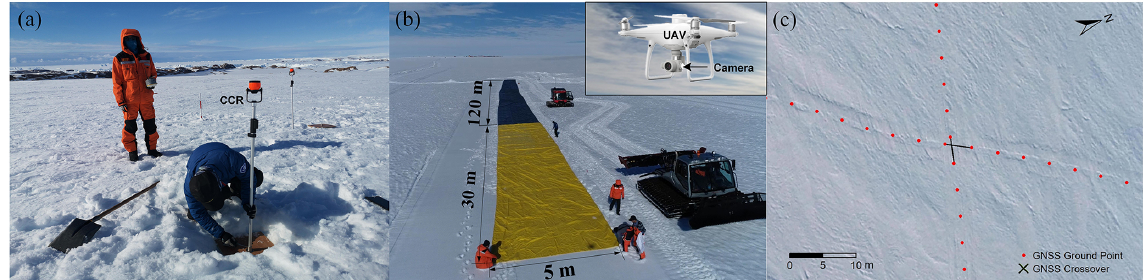
Figure 2. (a) A total of 10 CCRs were installed along a line across an ICESat-2 ground track at each site; (b) a two-coating RTS (5m × 150m with yellow and dark green coatings) was deployed near Zhongshan Station and surveyed by a UAV; and (c) example of a GNSS crossover point and snowcat tracks on a UAV